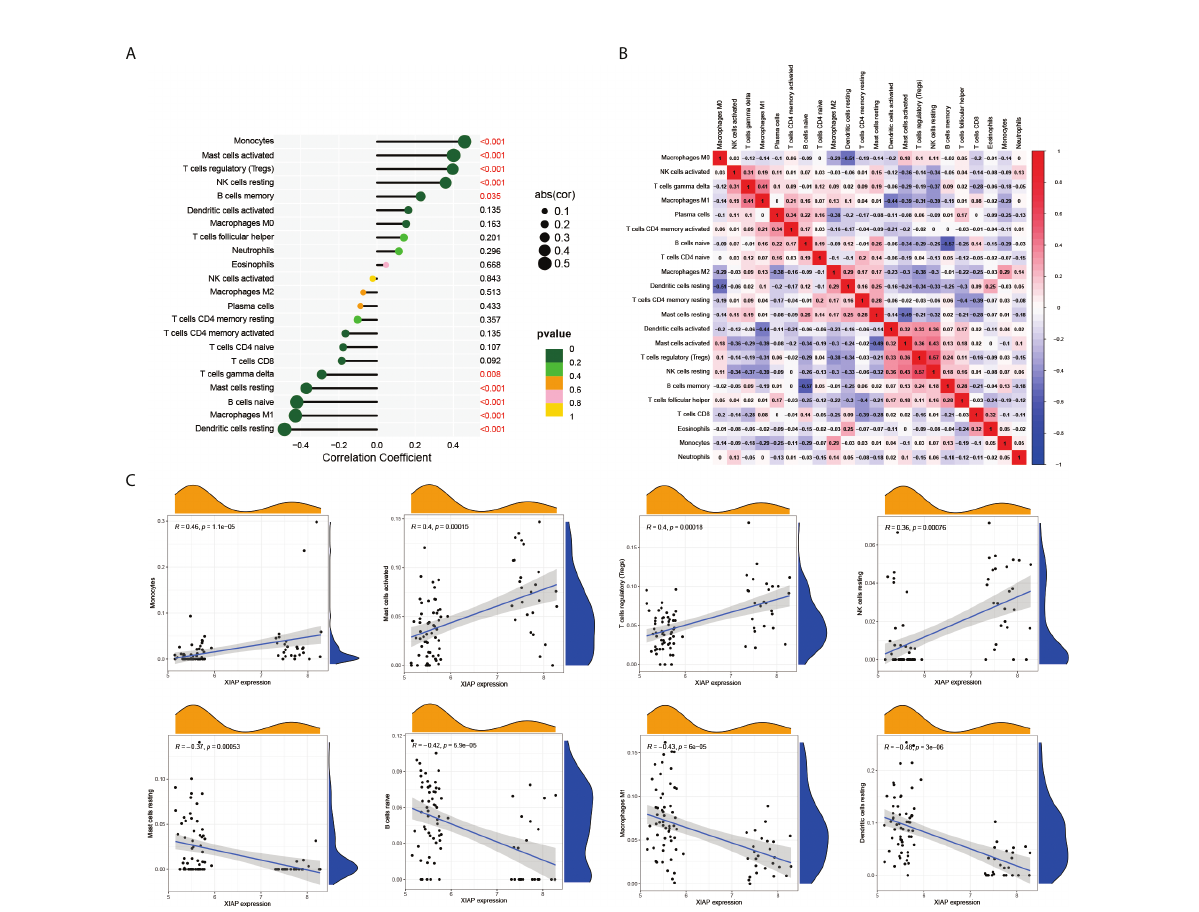
FIGURE 7 XIAP-related immune in fi ltration. (A) The relationship of 22 tumor in fi ltrating immune cells with LUAD-BM in CIBERSORT. (B) The proportions of different tumor in fi ltrating immune cell subpopulations were weakly to moderately correlated. (C) Monocytes, activated mast cells, T cell regulatory, and the resting NK cells were positively correlated with XIAP. In contrast, Mast cell resting, B cell naive, macrophages M1, and the resting dendritic cells were negatively related